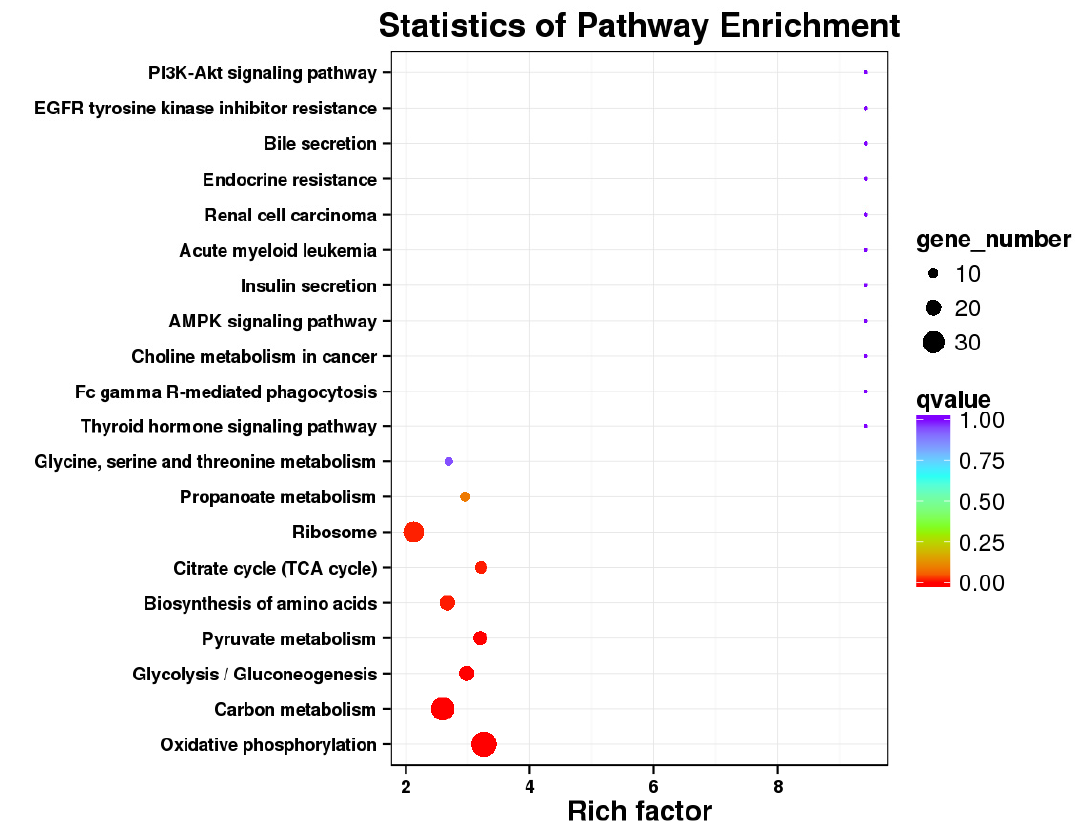
Figure 3. Scatter diagram of enrichment of DEGs KEGG pathways.